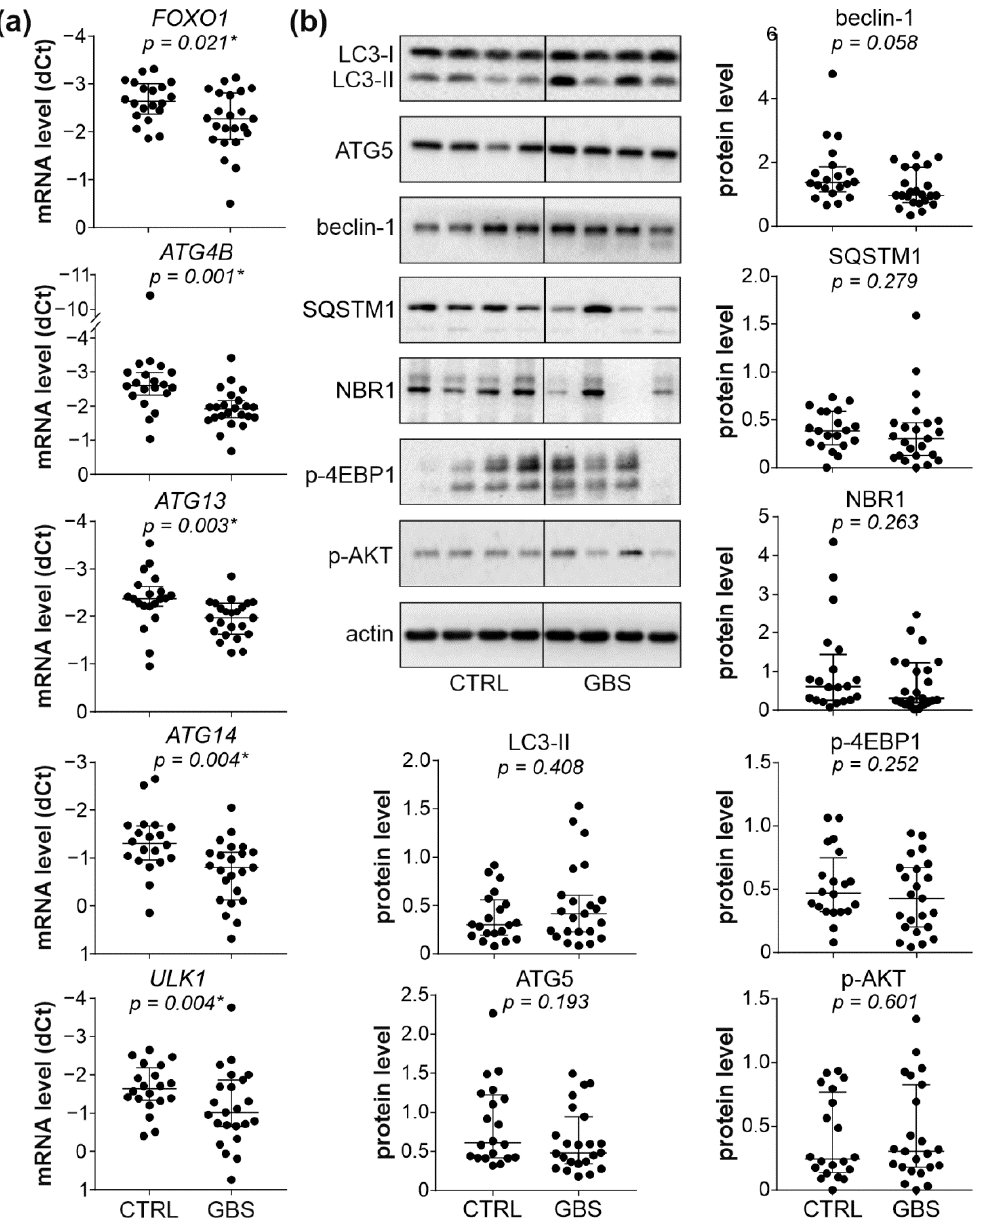
Figure 2. Autophagy and AKT/mTORC1 signaling in PBMCs of GBS patients. ( a , b ) PBMCs were isolated from control subjects (CTRL; n = 20) and GBS patients ( n = 23). ( a ) The mRNA levels of FOXO1, ATG4B, ATG13, ATG14, and ULK1 were determined by RT-qPCR and expressed as dCT values (lower dCT values correspond to higher expression). ( b ) The protein levels of LC3-I/II, ATG5, beclin-1, SQSTM1, NBR1, phospho-AKT, and phospho-4EBP1 were analyzed by immunoblotting, and the representative blots are shown together with densitometry data (relative to actin). ( a , b ) The dCT and densitometry values of each sample are presented, with horizontal lines representing median values and interquartile range (* p < 0.05, two-tailed Mann–Whitney U test).